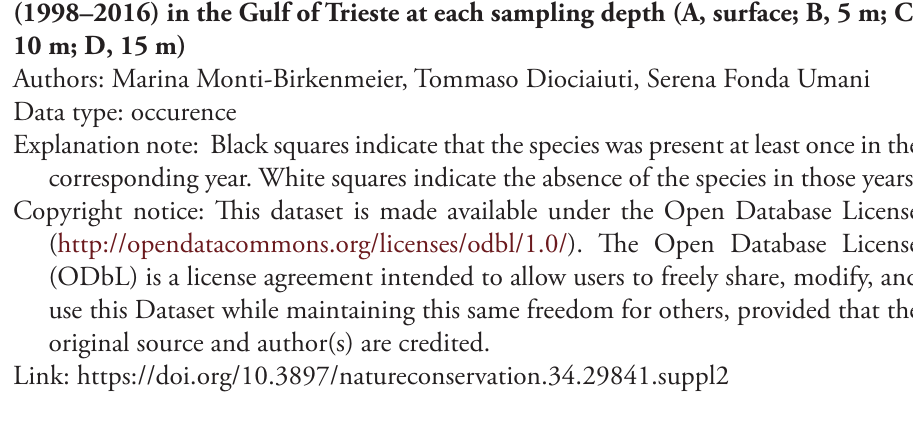
Table S2. Occurrence for each tintinnid species recorded in the studied